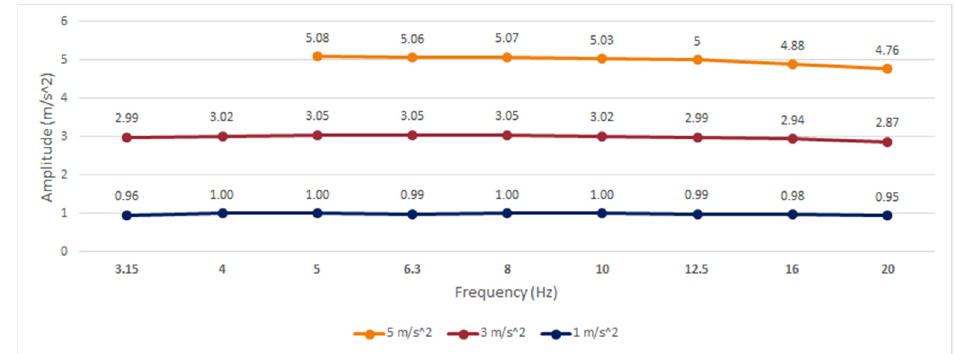
Figure 2. Frequency response of the smartwatch built-in accelerometer. Table 2. Percentage of deviation of the smartwatch compared to the reference accelerometer. Frequency (Hz)